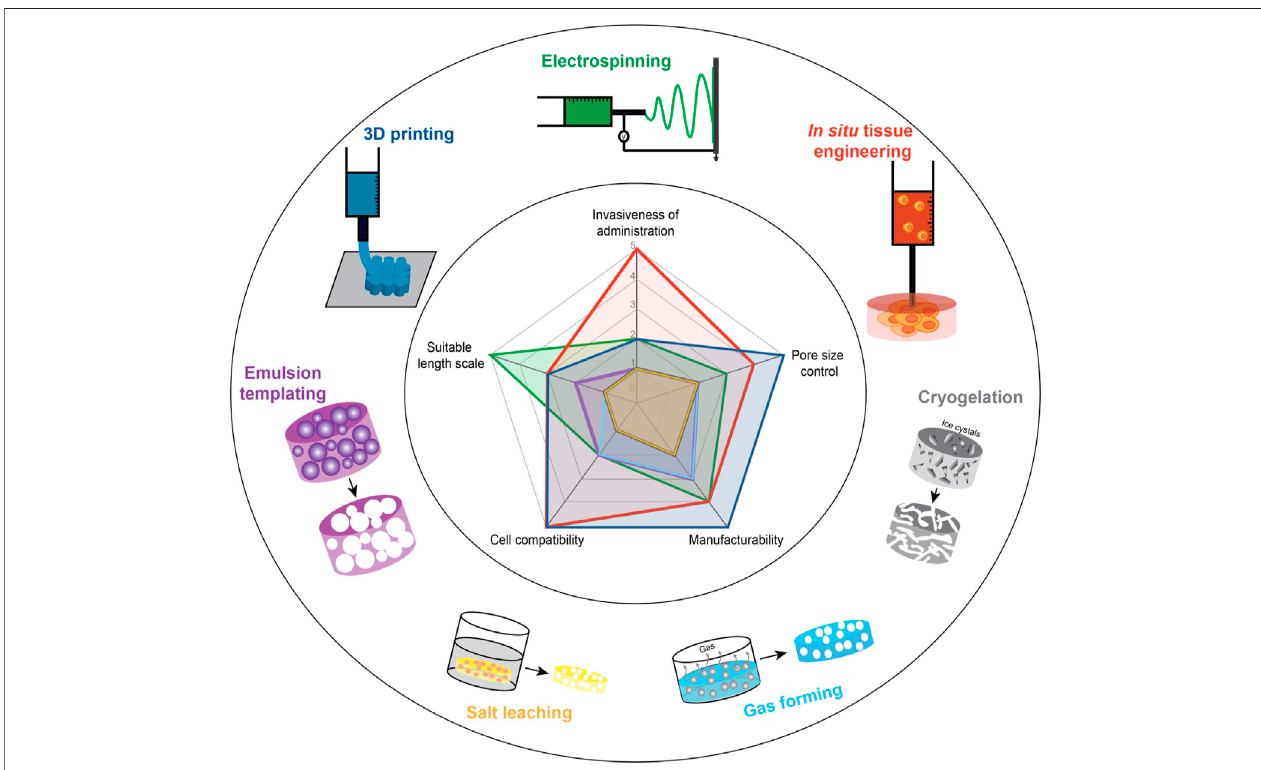
FIGURE 3 | Schematic of techniques to fabricate hydrogel-based macroporous scaffolds for tissue engineering. (Inset) Spider plot of the relative advantages of different macroporous scaffold formation techniques (scale 1 – 5: 1 = least advantageous, 5 = most advantageous) Note that the cryogelation plot overlaps with the salt leaching plot such that it is not clearly visible in the graph.